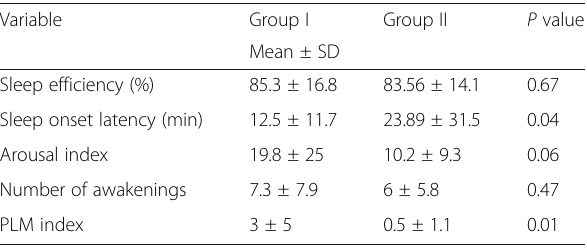
Table 2 Comparison between both groups regarding Sleep Latency and continuity measures